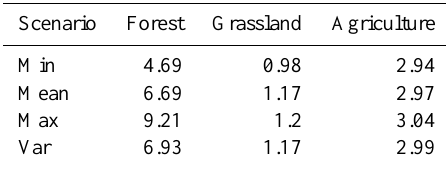
Table 4. Average summertime available fuel load for the Euro- Mediterranean region in terms of carbon (kg m − 2 ) according to the regional ORCHIDEE simulation. Scenario